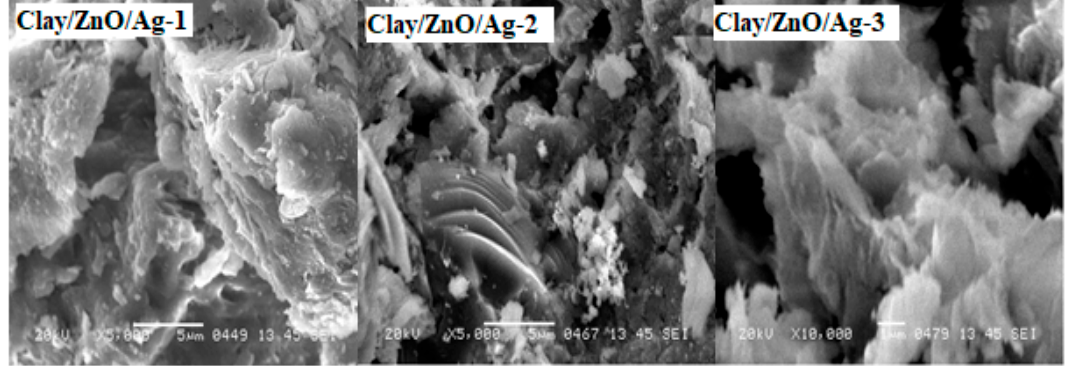
Figure 12. SEM micrograph of clay/ZnO/Ag-1, clay/ZnO/Ag-2 and clay/ZnO/Ag-3.